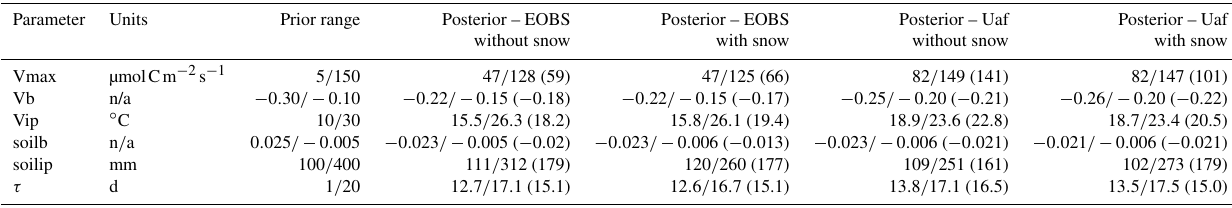
Table A1. Calibration parameters for the GPP module. Parameters, units, prior range and posterior range are shown (with parameter value in the plausible block) for both MAIDENiso versions and both flux